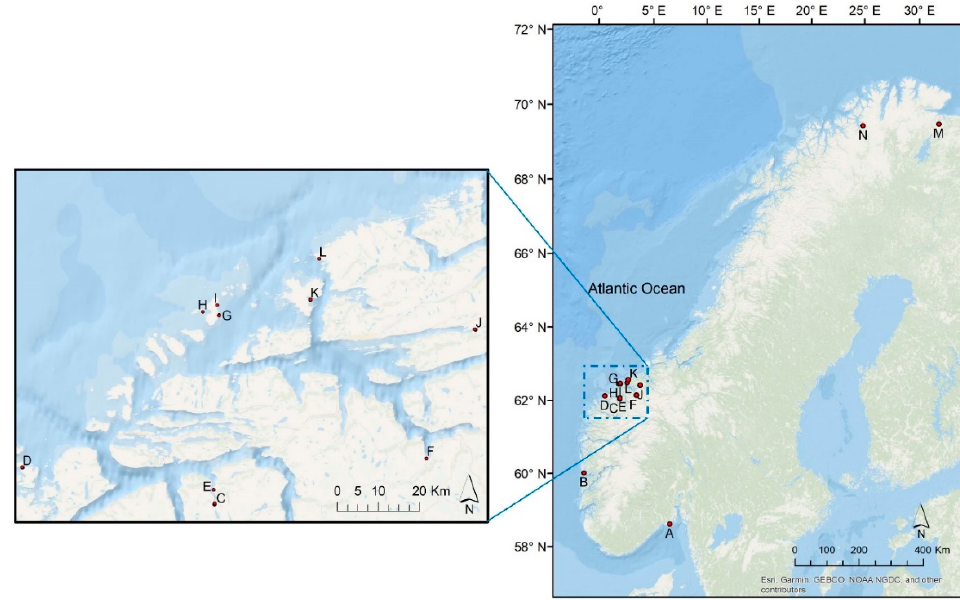
Figure 8. Sample localities (A–N) (Table 4) of collected Zostera marina samples along the Norwegian coast.